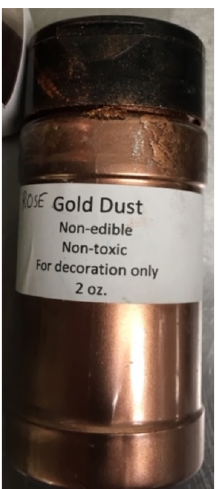
Image 3. Rose-gold luster dust vial used to provide decorative color to cake frosting, resulting in copper